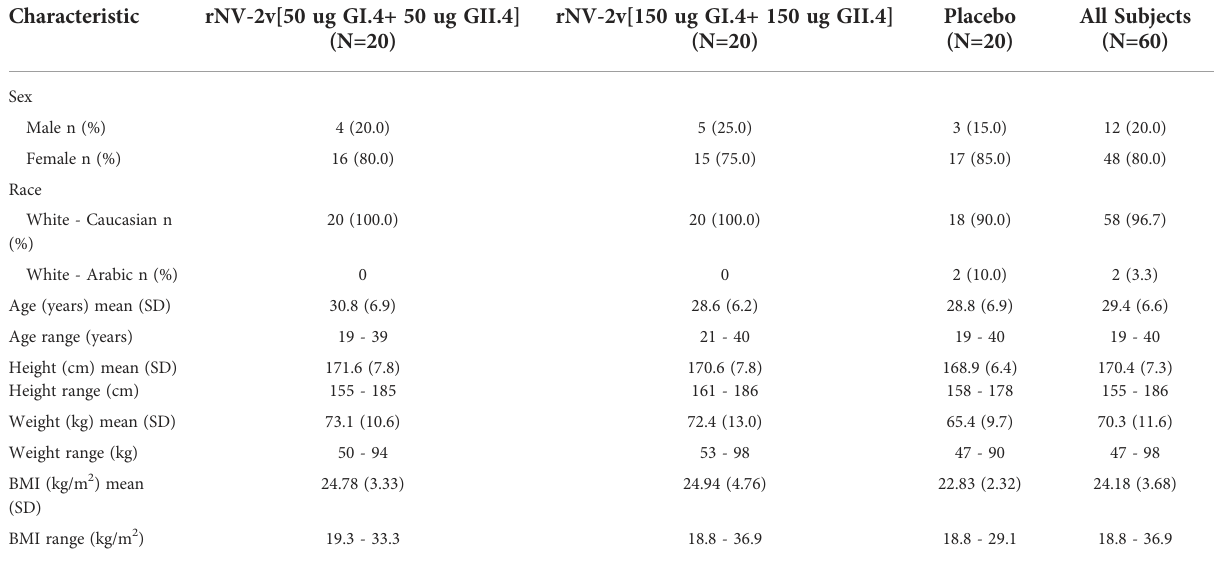
TABLE 1 Demographics and baseline characteristics of participants at enrolment.